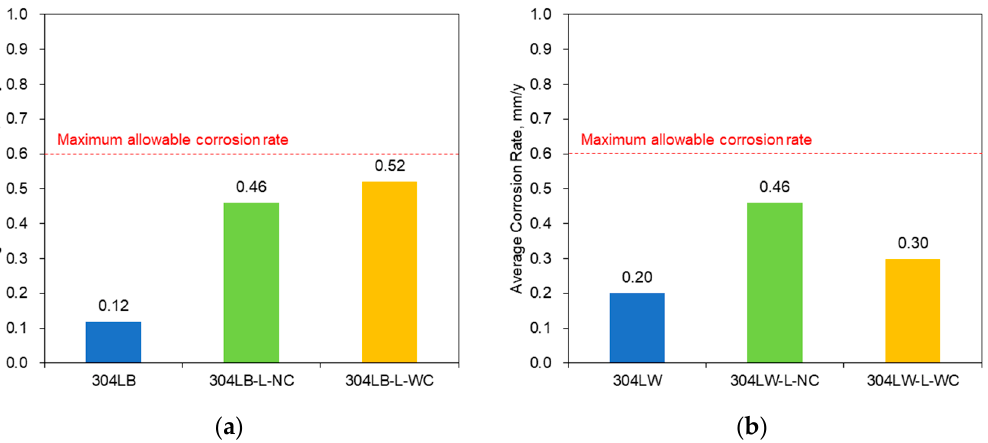
Figure 6. Effect of laser peening on the intergranular corrosion rate of 304L obtained from the immersion test in boiling 65% HNO 3 ; ( a ) Base metal, ( b ) Welded specimen. Table 5. The relationship between the DOS and IGC rate of 304L stainless steel by laser peening.